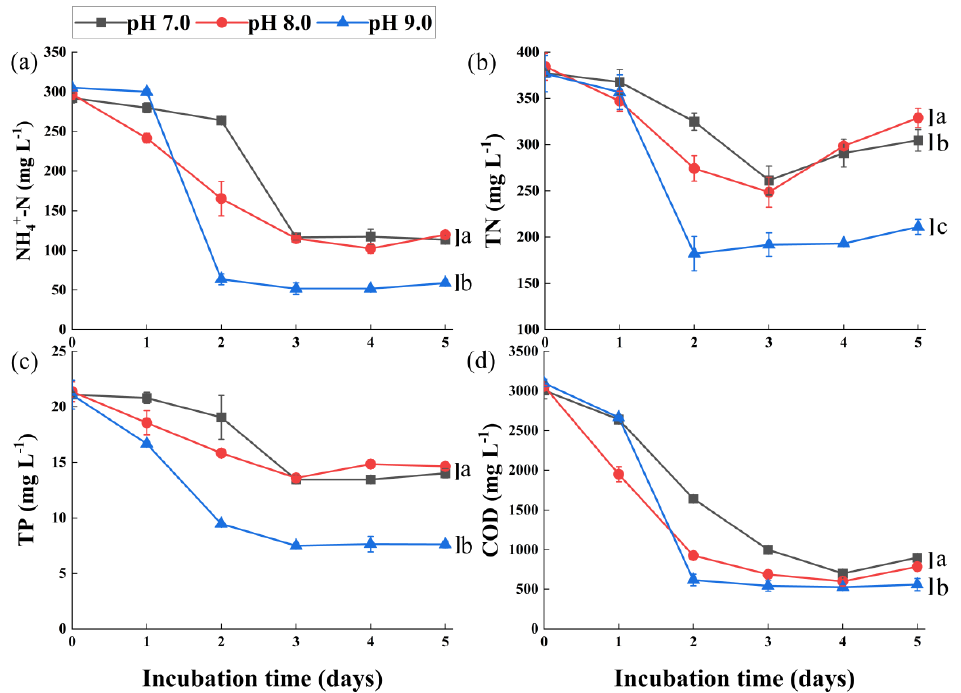
Figure 8. Concentrations of ammonium nitrogen (NH 4+ − N: ( a )), total nitrogen (TN: ( b )), total phosphorus (TP: ( c )), and chemical oxygen demand (COD: ( d )) for NCU-39 in different initial pH treatments in 5-fold diluted anaerobic digestion piggery effluents (ADPEs) pretreated by 3-day fungal decolorization. Tap medium was used as a control. Error bars represent standard deviations ( n = 3). Different letters indicate significant differences with Tukey–Kramer post hoc tests ( p <